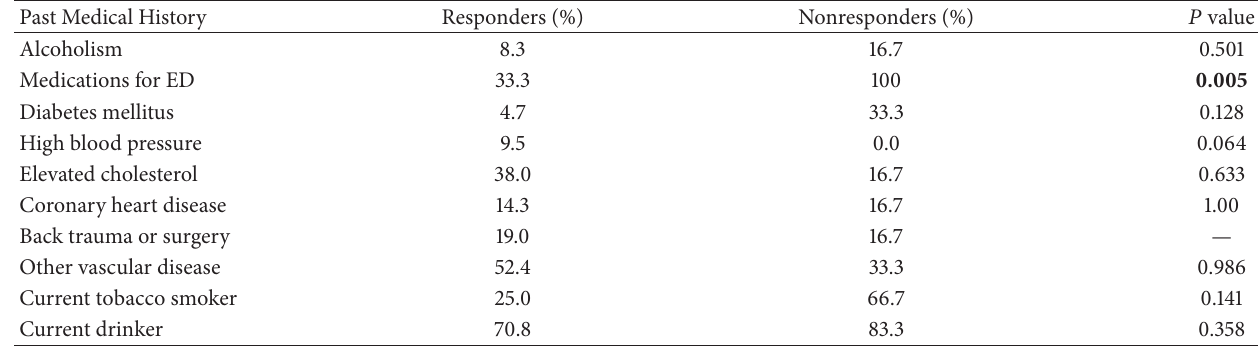
Table 5: Medical history of men either responded or not improved using EMDA.